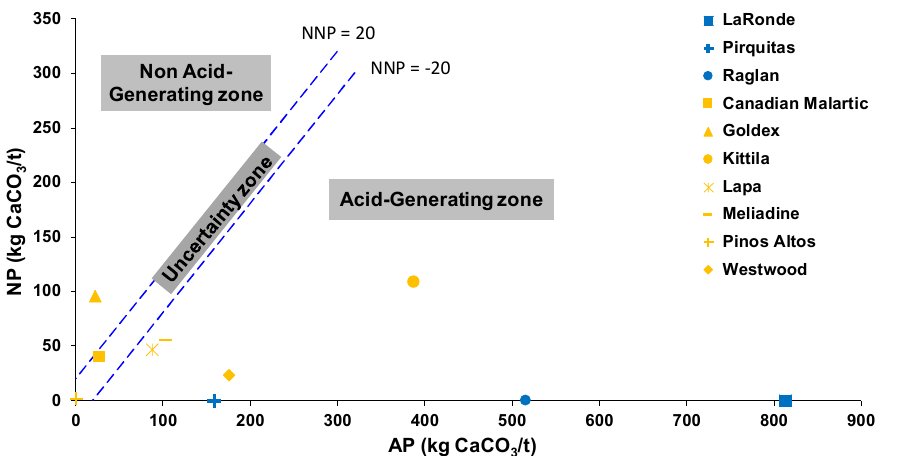
Figure 6. Net neutralization potential values for the ten ore samples calculated from the neutralization potential (NP) by Plante [52] and from the acid‐generation potential (AP) by Chopard et al. [54]. Despite the possible removal of certain minerals by flotation, all polymetallic samples studied will generate acid‐generating wastes. Therefore, contaminants will also be released. This is confirmed by the geochemical tests on the LaRonde and Pirquitas samples, as their pH is acidic (average of 4.2) and by the elemental concentrations found in the leachates. For gold ores, it was evaluated that all sulfides would go into the waste materials. Westwood, Kittilä and Meliadine would be acid generating, however the kinetic test results are in contradiction with this estimation. On the first hundred days of testing, as the pH of the leachates is comprised between 7.0 and 8.2 for these samples. This contradiction may be explained by the texture of the ores and by the short testing time. The lag time for acid generation is indeed an important consideration in acid rock drainage (ARD) prevention and the early results of geochemical testing may not be representative of long‐term behavior [58]. Conversely, the SEM observations have shown partially or totally liberated sulfides. Thus, the oxidation‐neutralization curve [59,60] was plotted to compare the cumulative extracted amounts of the main sulfide oxidation products (sulfates) and the main acid neutralization products (calcium, magnesium, and manganese) (Figure 7) to attempt to explain predictable results. The acid‐generating potential can be assessed by extrapolating the oxidation‐neutralization curve on a longer period and by projecting the initial sulfur and Ca + Mg + Mn initial contents of the sample.